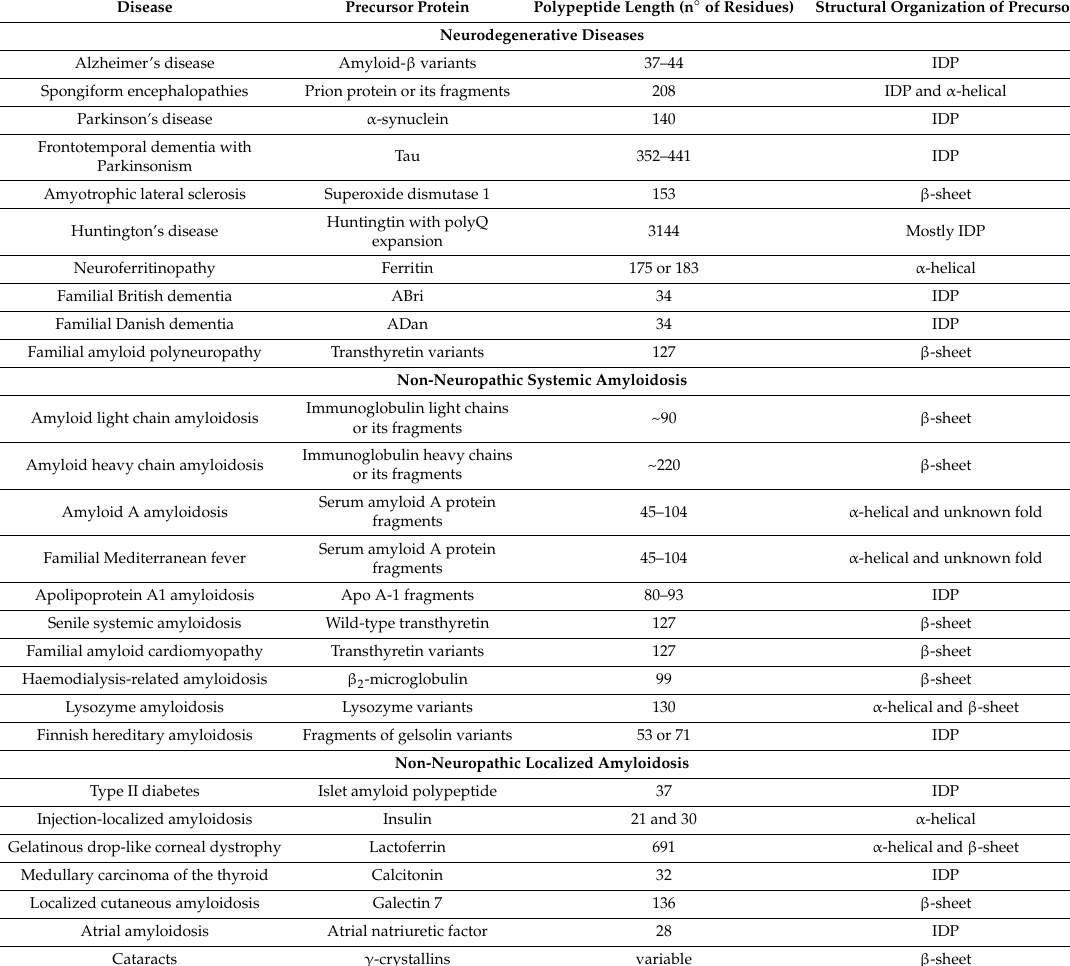
Table 1. Human diseases associated with protein misfolding and amyloid aggregation